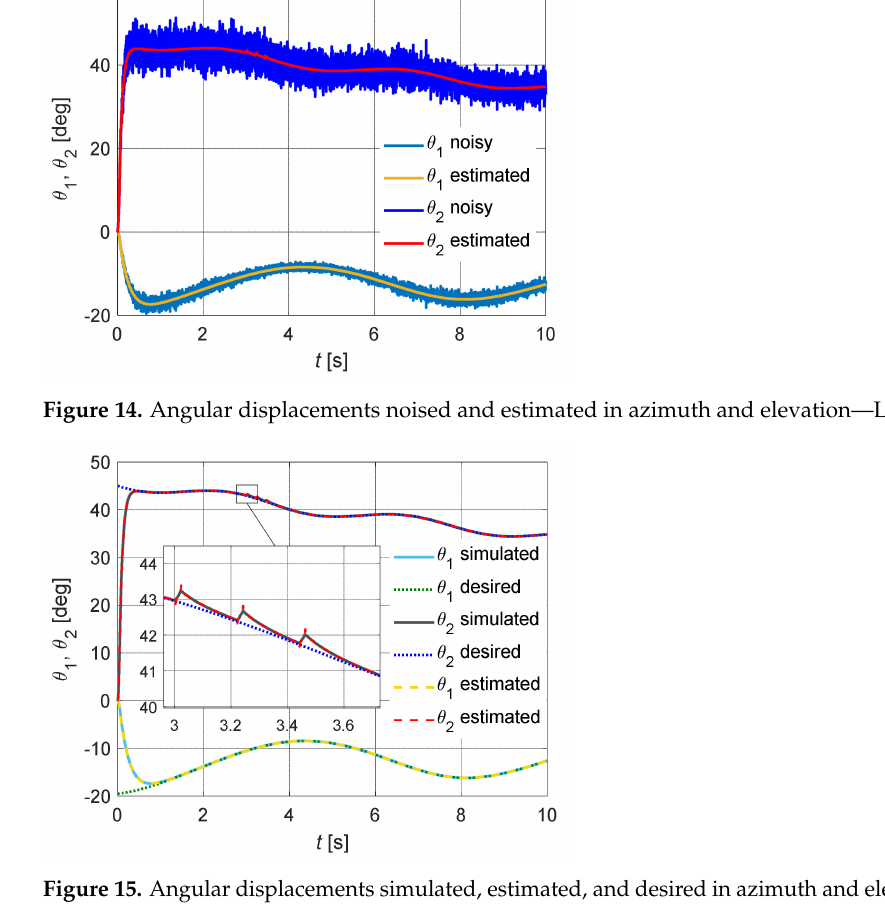
Figure 15. Angular displacements simulated, estimated, and desired in azimuth and elevation—LQG control.